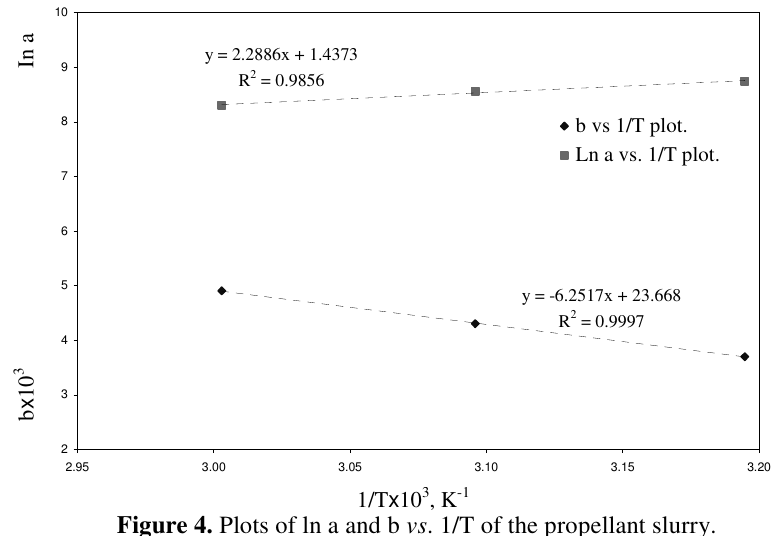
Figure 4. Plots of ln a and b vs . 1/T of the propellant slurry.